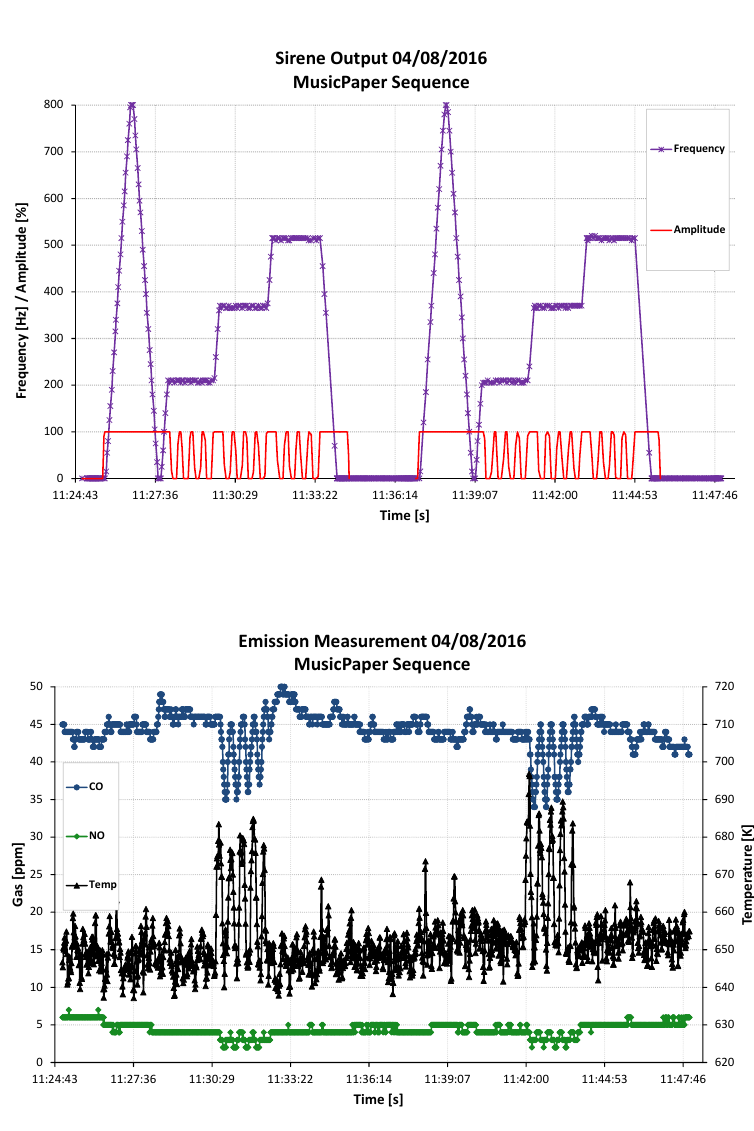
Figure 27. Test sequence using MUSICPAPER control software. ( Top ) Time-sequence repeated twice, starting with 2 frequency ramps followed by 3 frequency steps, at variable amplitudes of pulsation. ( Bottom ) Simultaneous exhaust gas